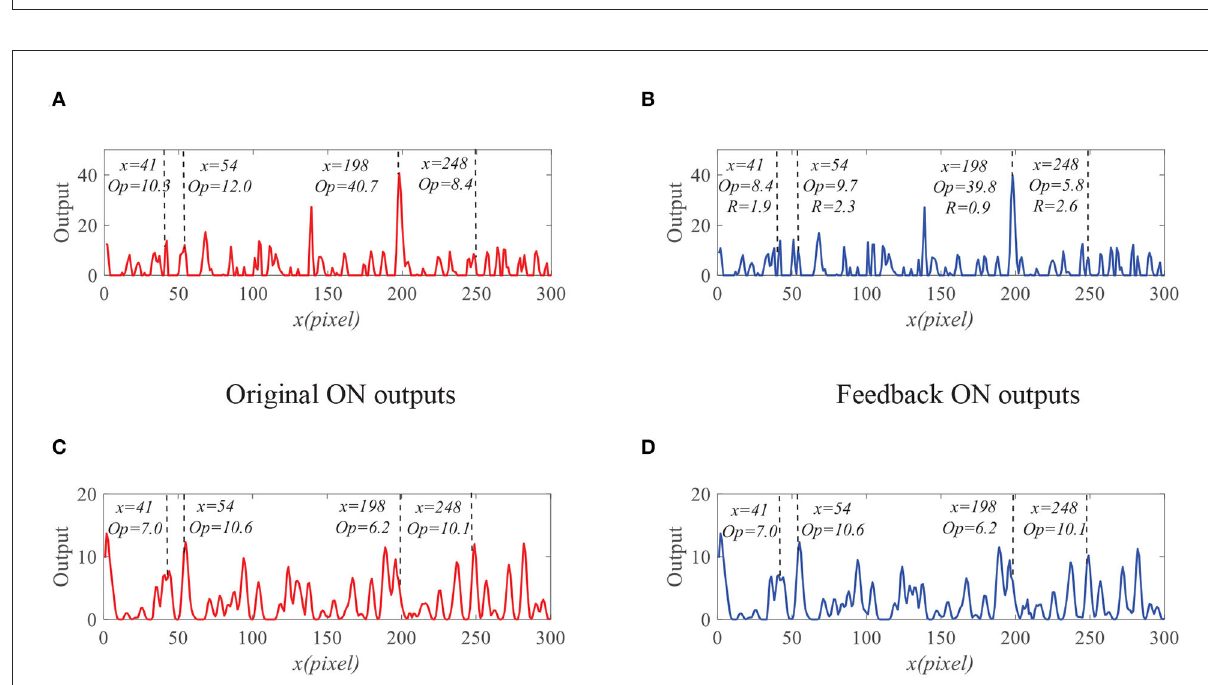
FIGURE9 The outputs of the medulla neurons. (A) The outputs of ON without feedback. (B) The outputs of ON with feedback. (C) The outputs of OFF without feedback. (D) The outputs of OFF with feedback.